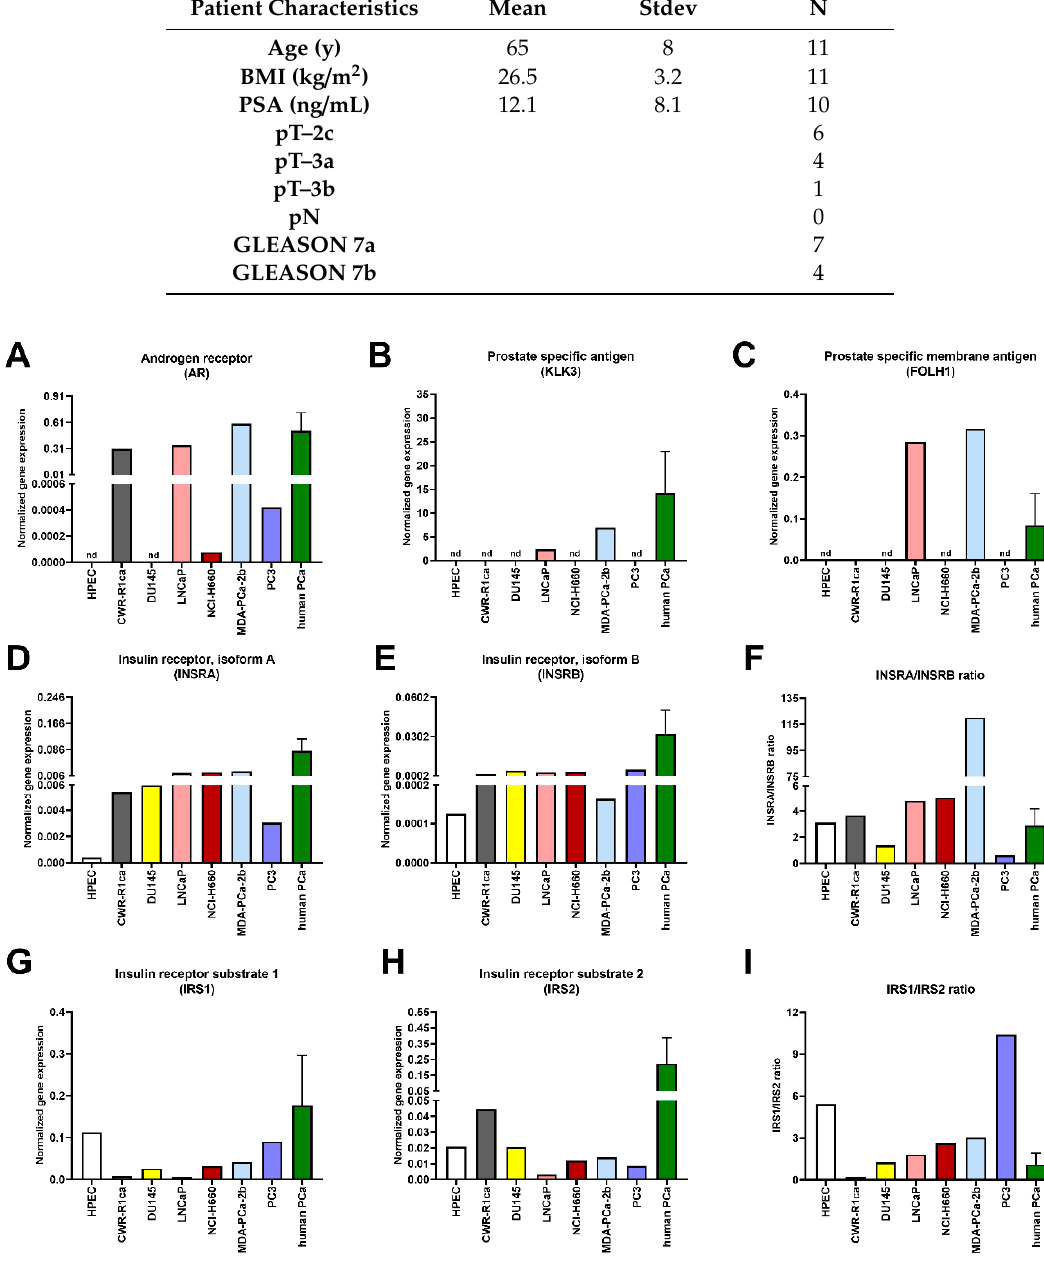
Table 2. Patient characteristics. Abbreviations: BMI: body-mass index, PSA: prostate-specific antigen, N: number of patients, Stdev: standard deviation. pT and Gleason scores represent prostate-cancer (PCa) pathological stages; pN denotes lymph-node status.